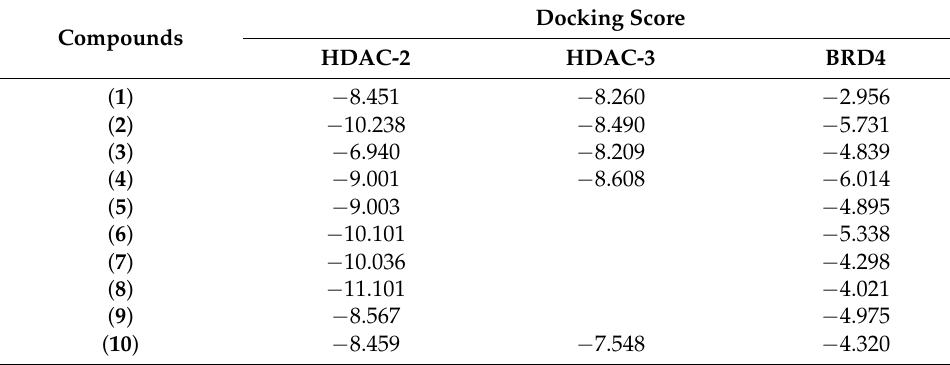
Table 1. Docking score of Glide (XP mode) for all compounds.